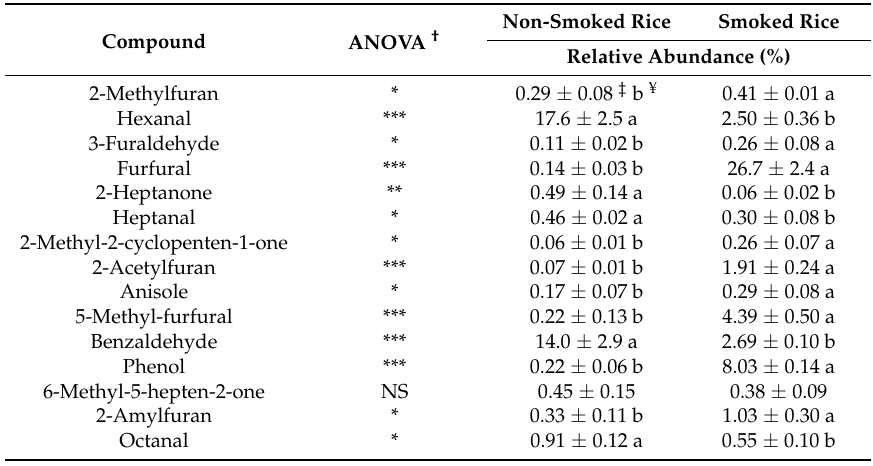
Table 3. Comparative composition of volatile compounds, by GC-FID, of smoked and non-smoked Iranian